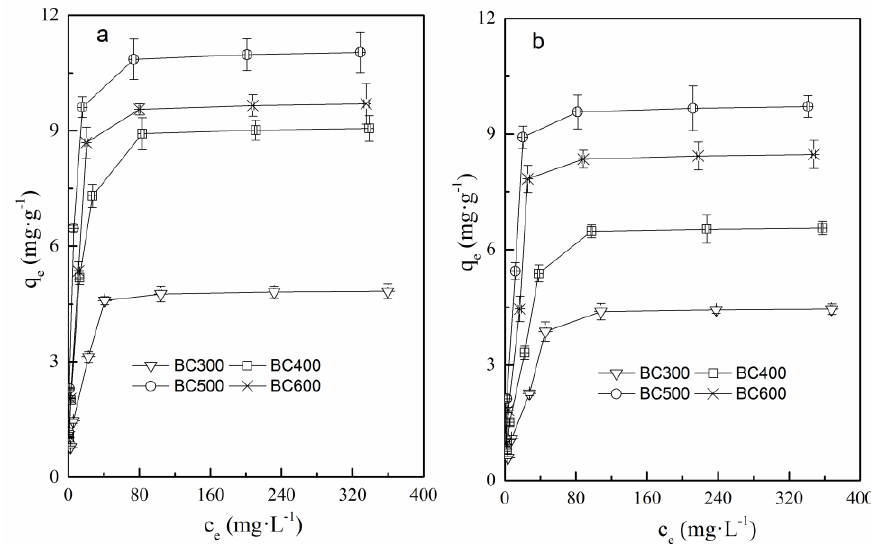
Figure 6. Adsorption isotherms of Cu(II) ( a ) and Zn(II) ( b ) by BCs (reaction temperature 25 °C; BC dosage 5 g · L − 1 ; initial solution pH 5.0; contact time 1440 min). Error bars represent standard error ( n = 3).